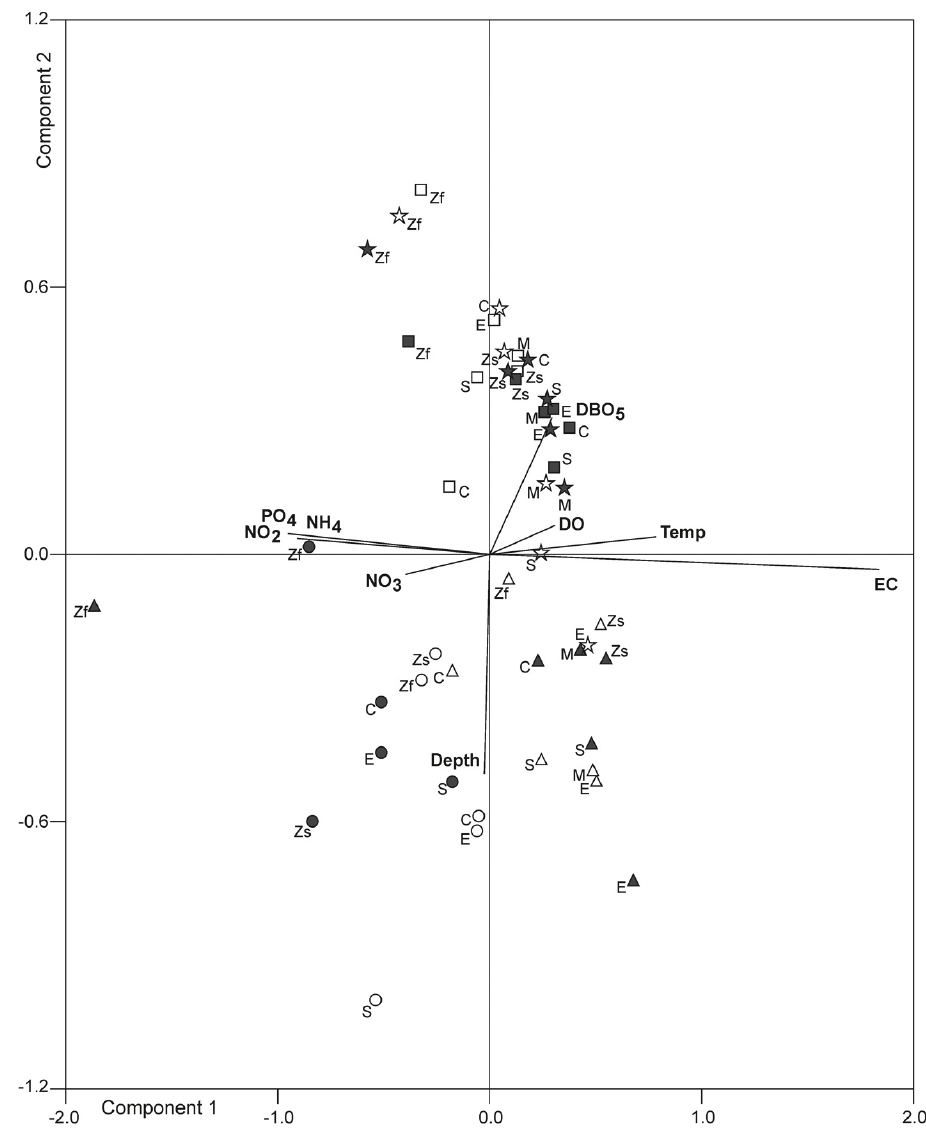
Figure 8. Principal Components Analysis (PCA) of the limnetic zone and of the mouth of tributaries of Escaba Reservoir in relation to physical and chemical variables (C = R. Chavarría; M = R. Las Moras; E = R. El Chorro; S = R. Singuil; Zs = limnetic zone (subsurface); Zf = limnetic zone (bottom)). (Winter/2010 = □ ; Spring/2010 = ○ ; Summer/2011 =  ; Autumn/2011 = ☆ ; Winter/2011 =  ; Spring/2011 = ● ; Summer/2012 = ▲ ; Autumn/2012 = ★